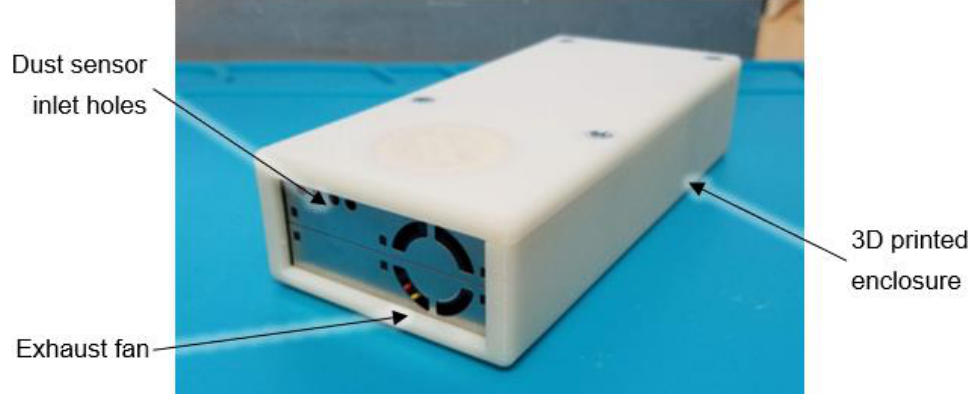
Figure 1. PMS5003 dust sensor mounted in 3D printed enclosure.